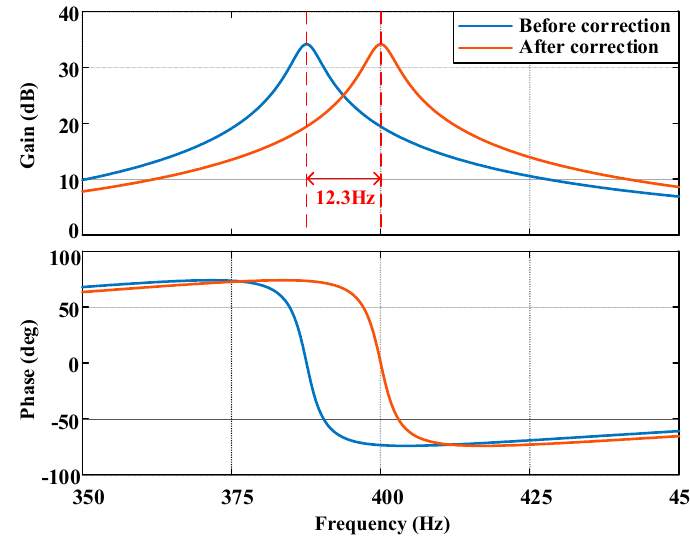
Figure 18. The bode diagram of G PR before and after correction.